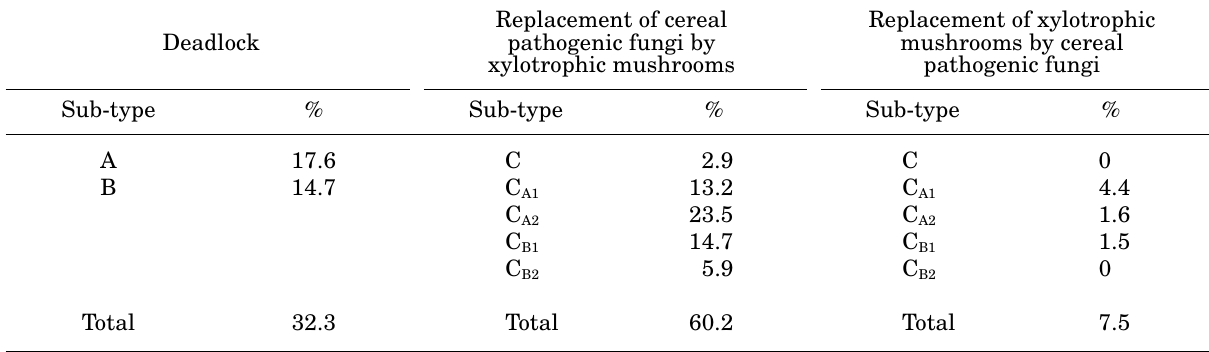
Table 2. Frequency of type and subtype of interactions between mycelium of xylotrophic mushrooms and pathogenic fungi of cereals in dual culture experiments on potato dextrose agar medium, expressed as a percentage of the total number (204) of pairings